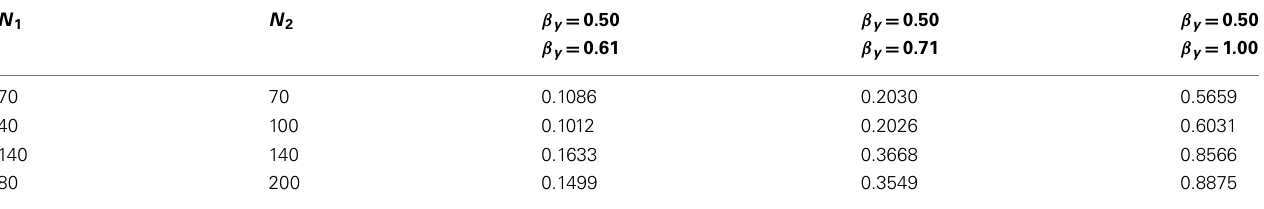
Table 4 | Moderated regression coefficients.